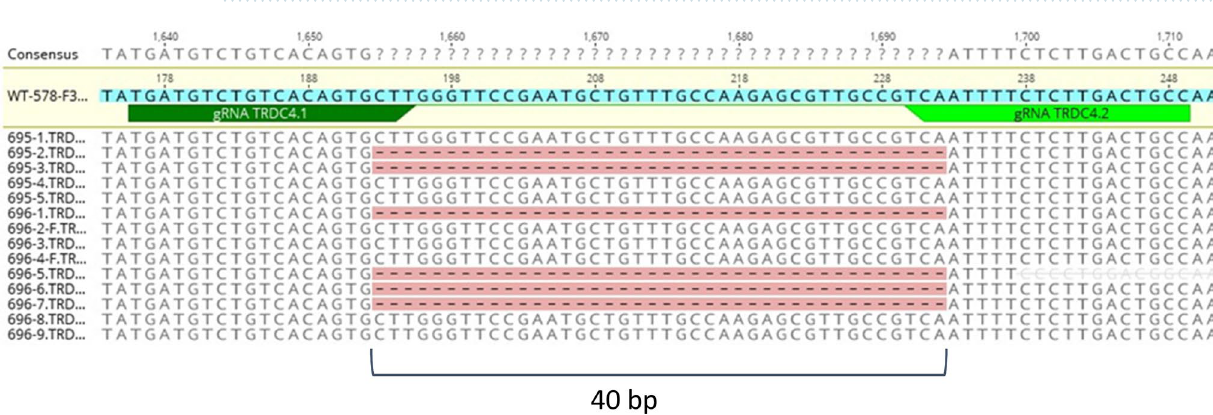
Figure 2. Sequencing data of pigs generated by intracytoplasmic microinjection of the CRISPR/Cas9 construct targeting the porcine TRDC-locus. Sequencing results confirmed the PCR results (Fig. 1) that pigs 695-2, -3 and pigs 696-1, -5, -6, -7 carry a homozygous knockout of the TRDC locus consisting of a clear 40 bp deletion. For each piglet, six samples were sequenced. None of the piglets were monoallelic knockouts (the binding sequences of the guide RNAs are indicated by green